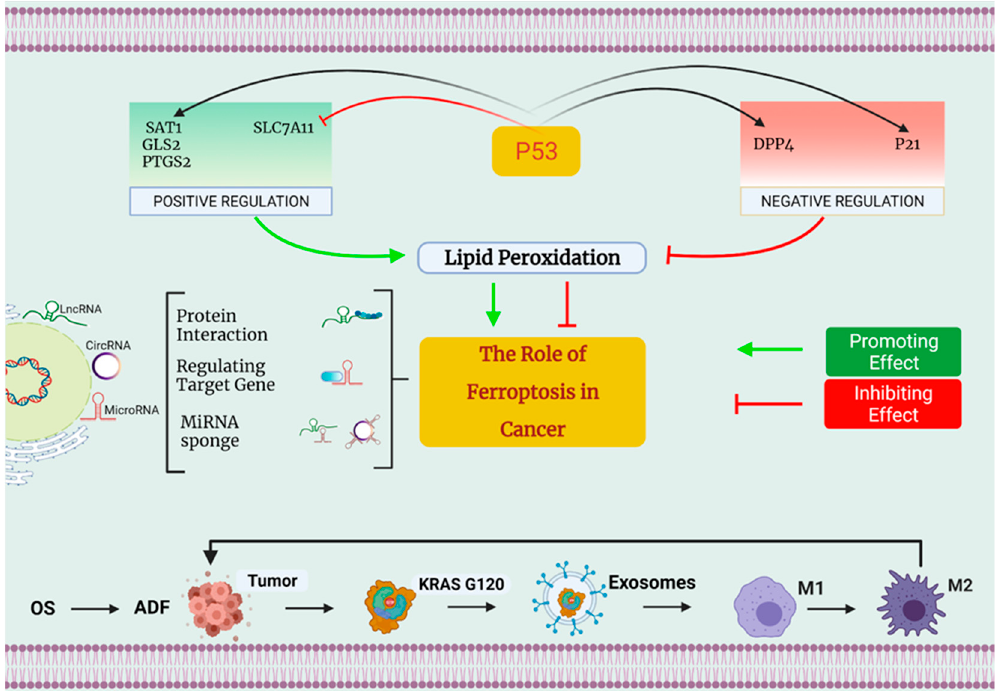
Figure 2. The involvement of ferroptosis in the development of cancer. First and foremost, p53 can control ferroptosis both favorably and negatively. On the one hand, p53 may promote ferroptosis by decreasing the expression of SLC7A11 while simultaneously inhibiting the regulation of SAT1, GLS2, as well as PTGS2. On the other side, p53 can reduce ferroptosis by inhibiting DPP4 action and increasing the production of the protein p21. Second, small nucleolar RNA (snRNA) is a new regu- lator of ferroptosis control, and this includes long noncoding RNA (lncRNA), microRNA, and circRNA. Differential mechanisms that regulate ferroptosis may be classified into three types: some suggest that LINC00336 and circ-TTBK2 might act as competitor endogenous RNAs (ceRNAs), binding to miRNAs and regulating miRNA production, hence altering the ferroptosis process. The microRNAs MiR-214 and MiR-137 may influence the formation of genes implicated in ferroptosis. lncRNAs p53RRA enhance ferroptosis through interacting with ferroptosis-related proteins, accord- ing to research. Third, under conditions of OS, autophagy-dependent ferroptosis (ADF) promotes pro-tumorigenic M2 macrophage polarization and the production of tumor-associated macro- phages (TAMs), both of which are necessary for cancer development. 5.1. Breast Carcinoma The solute carrier family 7 member 11 (SLC7A11) is a part of the cysteine-glutamate transporter which acts as a major component in tumorogenesis. In a similar way to SLC7A11, the MUC1-C (transmembrane oncoprotein) is connected to GSH production and causes redox stability in triple-negative breast cancer cell lines. Studies have revealed that MUC1-C interacts with CD44v (a variation of CD44), increasing the strength of SLC7A11 upon that cell membrane and resulting in an increase in GSH production and ferroptosis inhibitory activity [74]. Following treatment with Gpx inhibitors, the transcrip- tion of the pentaspanin protein (prominin-2), which has been involved in the control of lipid dynamics, increases in adherent cells such as breast cancer cells [93]. Because of the creation of ferritin-containing vesicles bodies and exosomes that induce Fe export, prominin-2 helps to prevent excessive buildup of free Fe in cells and the development of ferroptosis. Moreover, the ferroptosis is also increased by the suppression of multivesicu- lar bodies, which suggests that prominin-2-induced exosome production may serve as a protective strategy against ferroptosis [94]. 5.2. Pancreatic Carcinoma